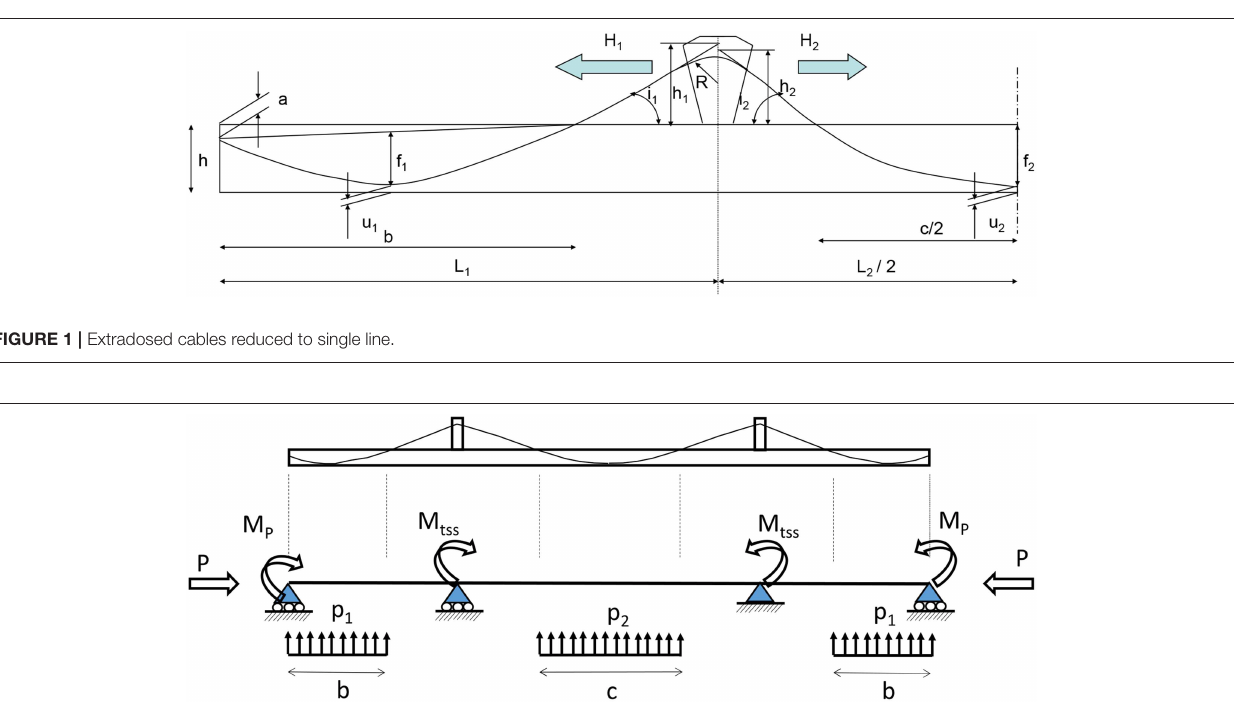
FIGURE 2 | Effect of prestress as external loads.